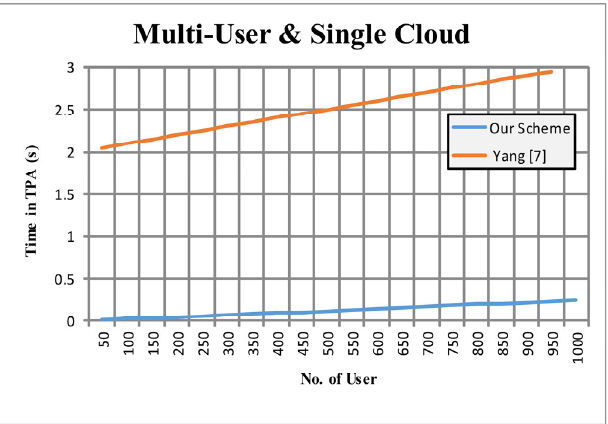
Figure 6. Computation cost on semi ‐ trust server with multi smart device user and single cloud.